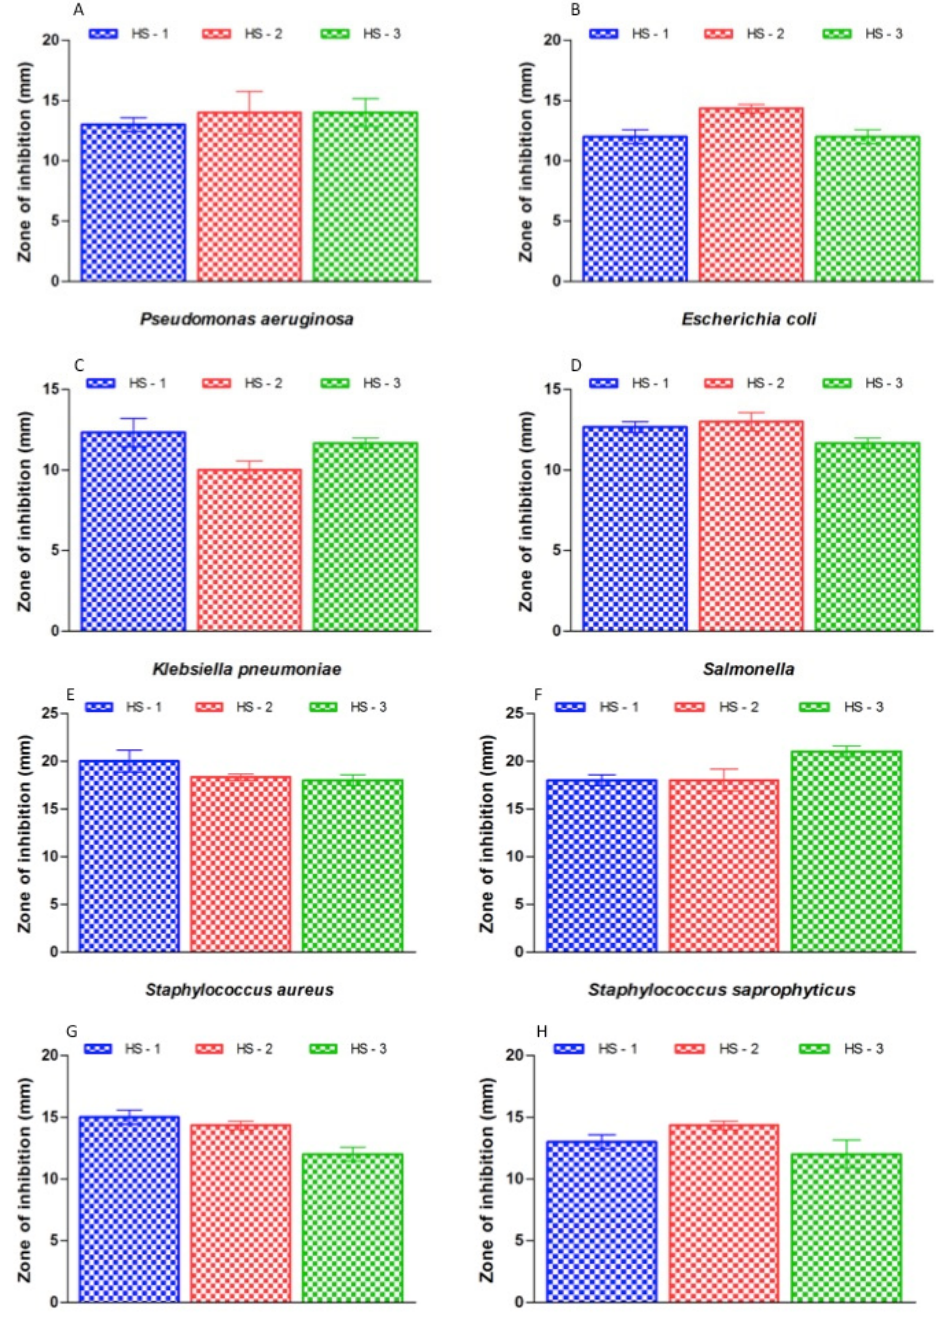
Figure 5. ( A – H ). Inhibitory efficacy of the honey with AgNPs. (HS-1: 20% honey with silver nanoparticles; HS-2: 40% honey with AgNPs; HS-3: 80% honey with AgNPs). ( A ) Pseudomonas aeruginosa ; ( B ) Escherichia coli ; ( C ) Klebsiella pneumoniae ; ( D ) Salmonella ; ( E ) Staphylococcus aureus ; ( F ) Staphylococcus saprophyticus ; ( G ) Streptococcus pyogenes ; ( H ) Enterococcus faecalis.